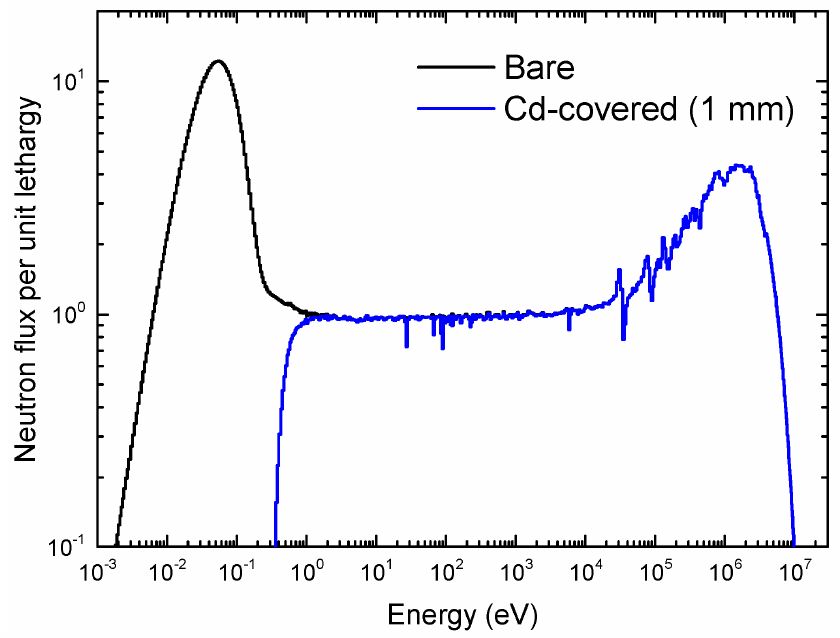
Figure 1. Neutron spectra in the Jozef Stefan Institute (JSI) TRIGA pneumatic tube (PT) irradiation channel, corresponding to bare and Cd-covered irradiations, obtained by means of Monte Carlo simulations and subsequently characterized based on experimental neutron activation measure- ments.